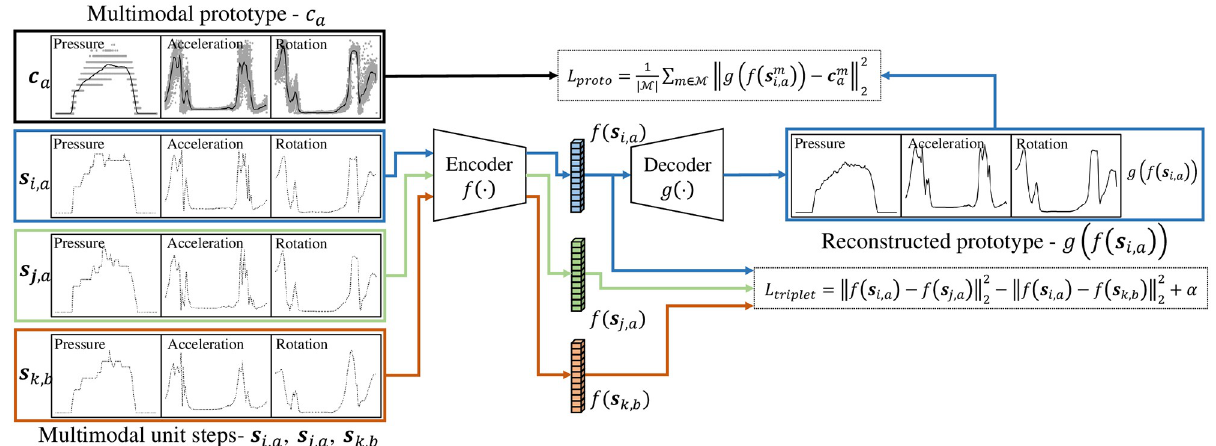
Fig 5. Illustration of the prototyping encoder–decoder with triplet loss. The overall loss function is a linear combination of the multimodal triplet loss function and the prototyping loss function.